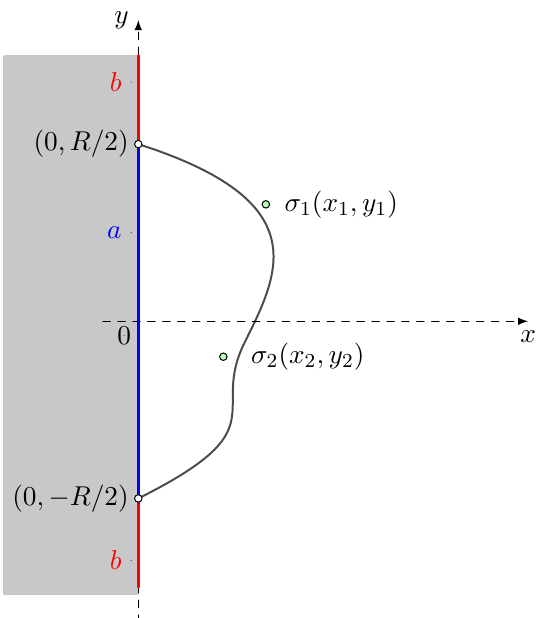
Figure 1. The half-plane geometry with boundary conditions B bab leading to the formation of a droplet in the halfplane x > 0 with pinning points in (0 , ± R/ 2) . Green circles indicate the order parameter fields σ 1 and σ 2 appearing in correlation functions considered in this